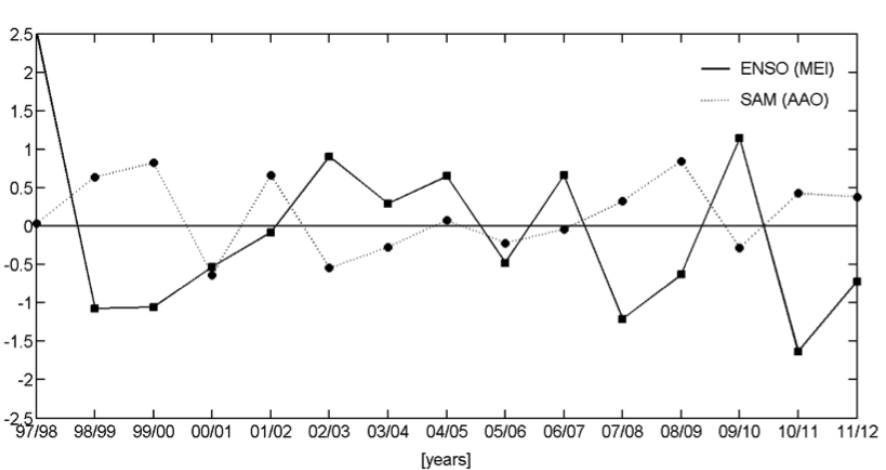
Figure 1. Time series (dimensionless) of the annual Multivariate ENSO Index (representing the ENSO, solid line) and the Antarctic Oscillation index (representing the SAM, dashed